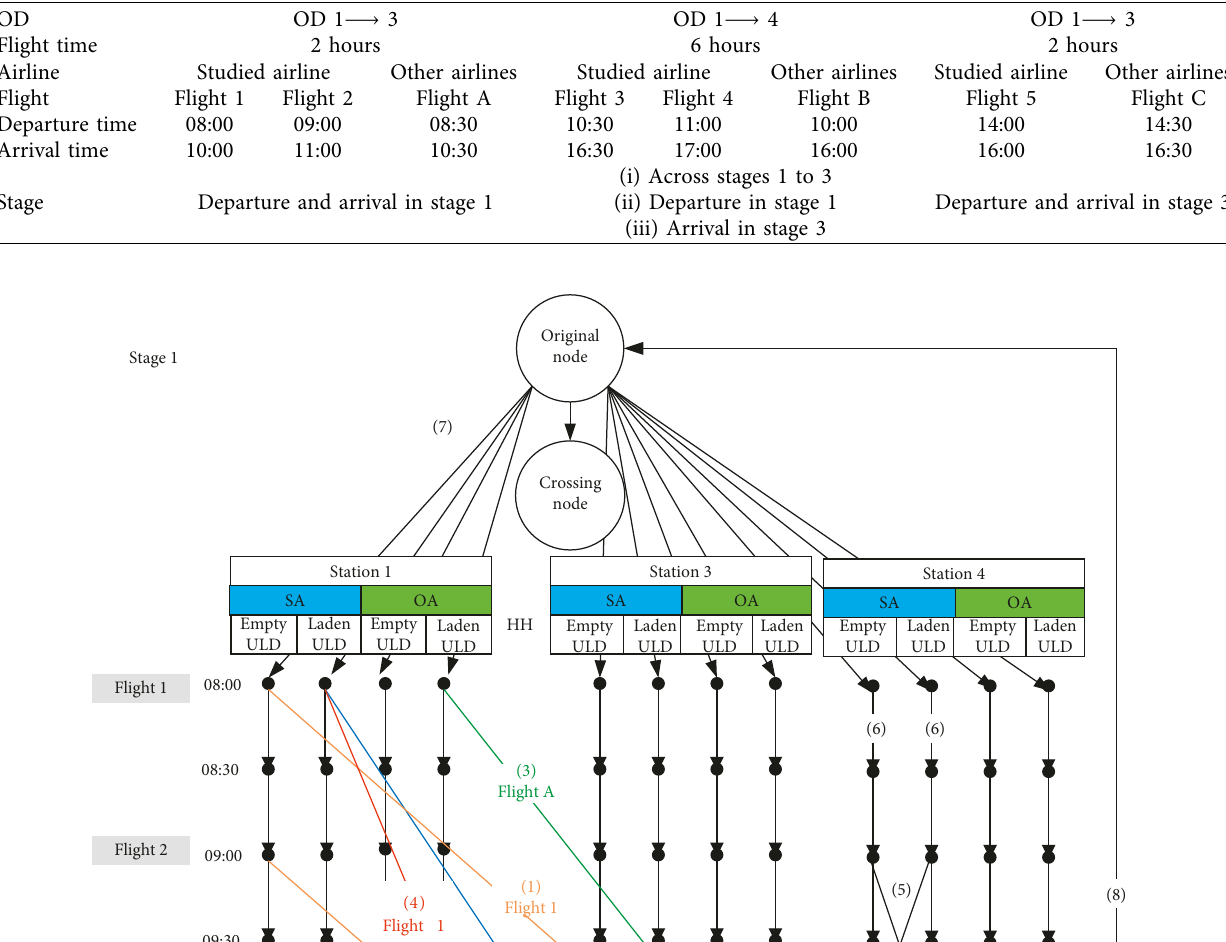
Table 1: An example with stages 1 and 3 and ODs 1